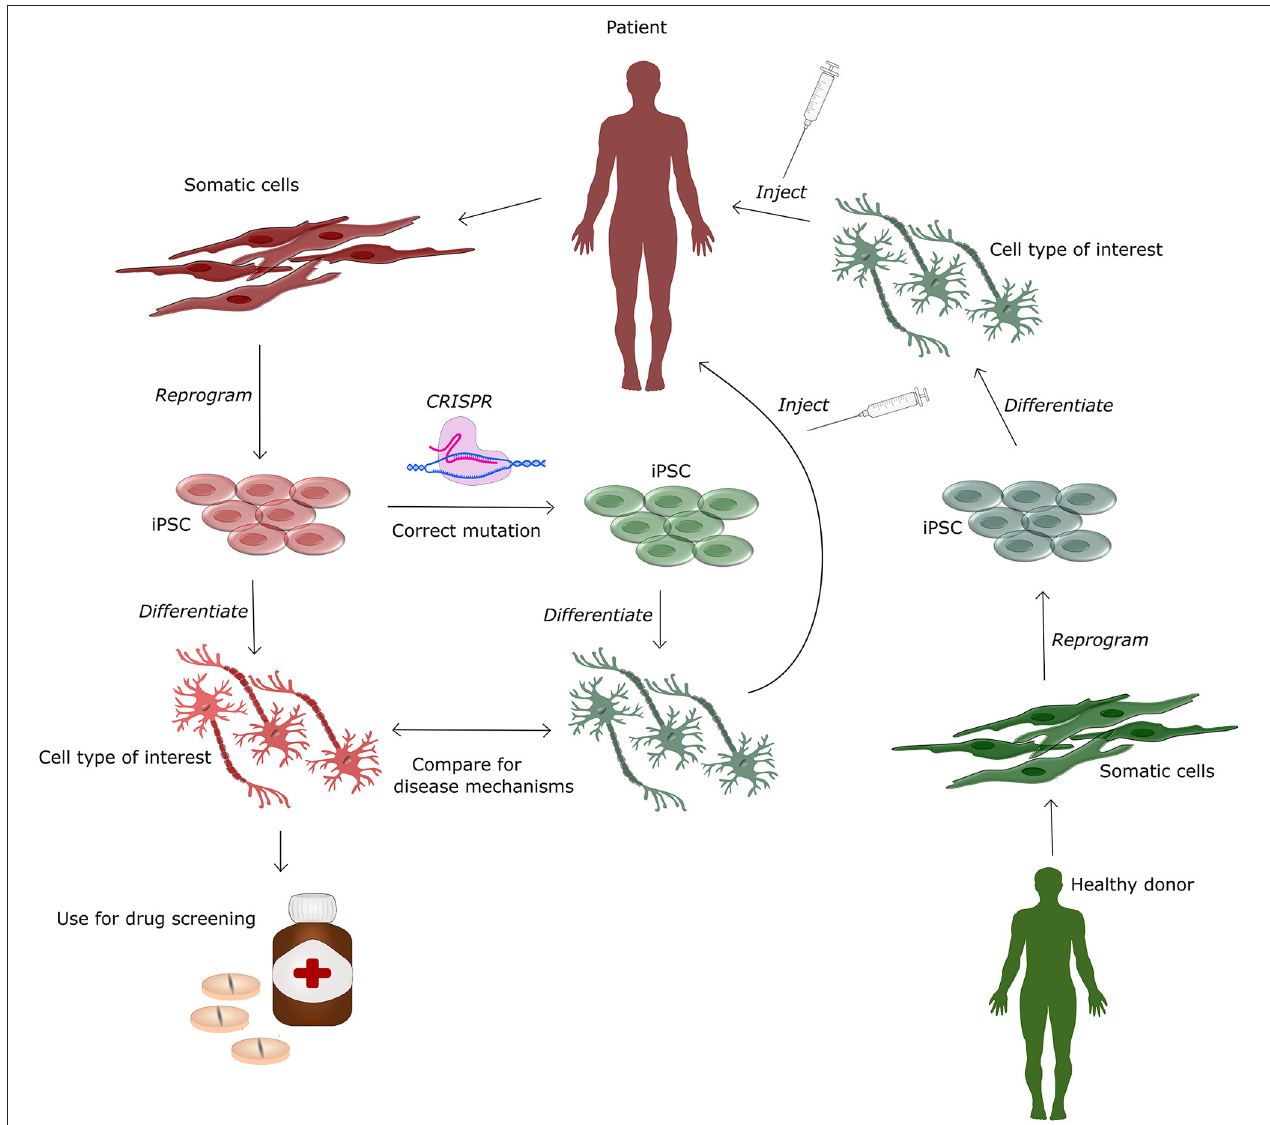
FIGURE 3 | Human induced pluripotent stem cells (hiPSC) for treatment and modeling of genetic diseases. This figure illustrates the various applications of hiPSC, which can be generated from a healthy donor and afterwards differentiated into specific cell types for cell-based therapy or downstream drug screening in in vitro based cell systems. The patient derived hiPSC can additionally be genetically corrected using CRISPR-Cas9. This isogenic cell-line can be differentiated and compared to cells from the patient to obtain knowledge of disease and mutation specific mechanisms. Differentiated gene corrected hiPSC can be injected back into the patient for autologous cell